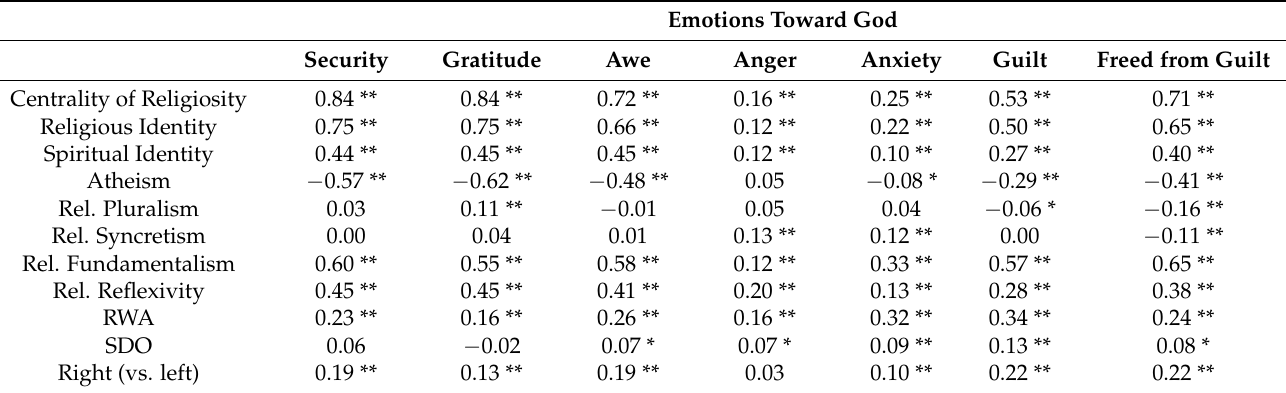
Table 2. Correlations of centrality of religiosity and the religious and political orientations with the emotions toward God ( n = 824 to